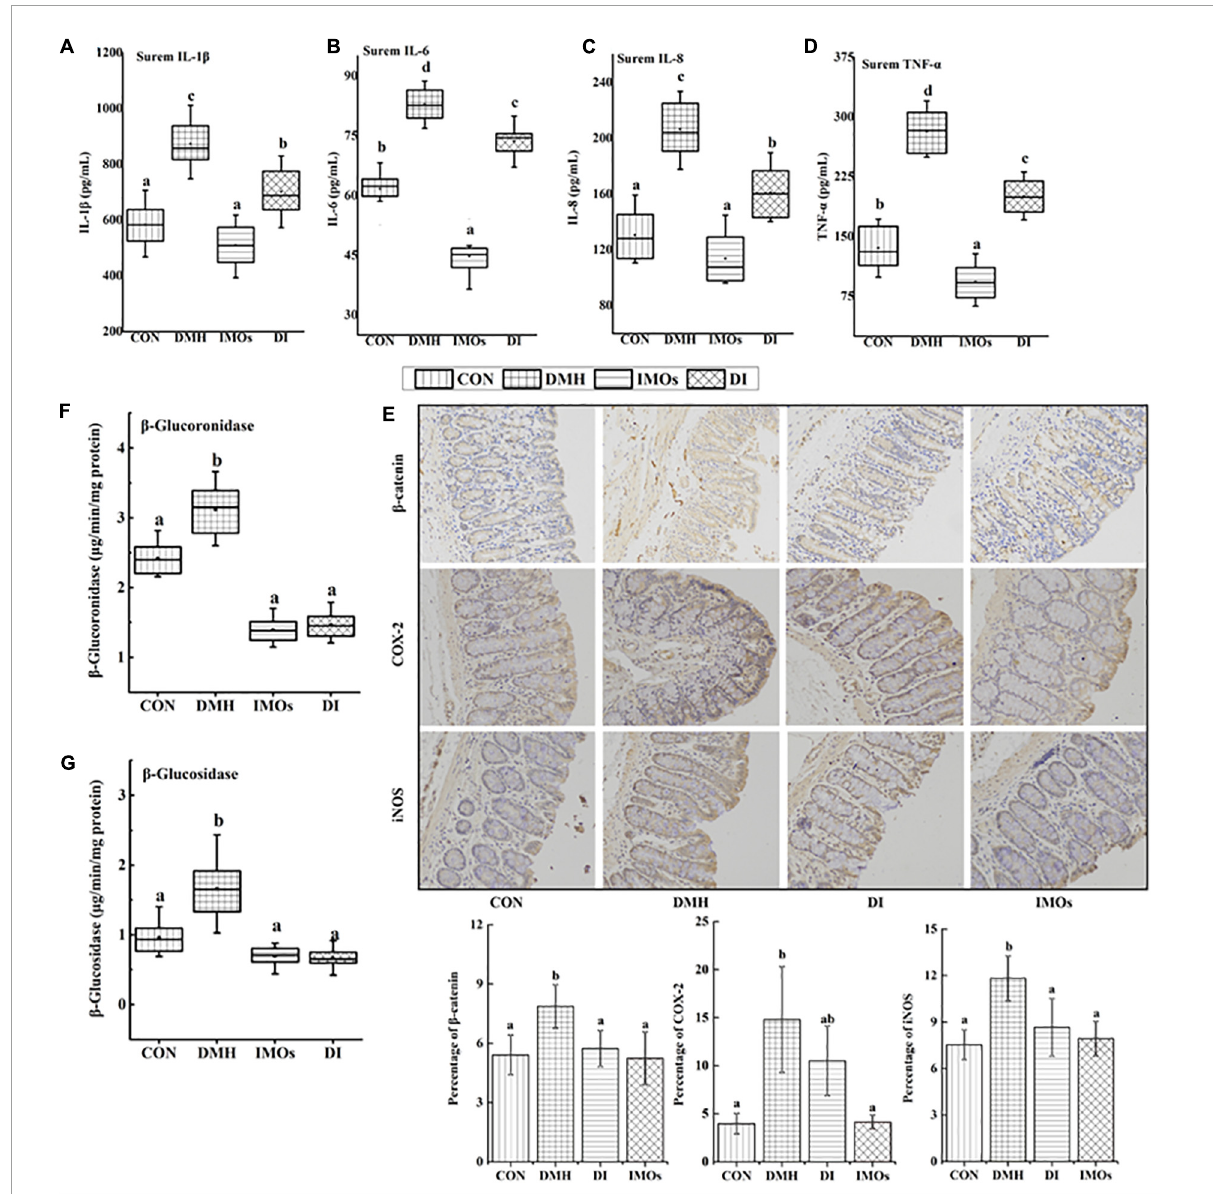
FIGURE2 The levels of (A) IL-1 β , (B) IL-6, (C) IL-8 and (D) TNF- α in rat serum. (E) Immunohistochemistry of β -catenin, COX-2 and iNOS in rat colonic tissue. β -glucoronidase and positive expression rates of β -catenin, COX-2 and iNOS in colonic tissues were analysed using Image Pro-Plus 6.0 software. The levels of (F) β -glucoronidase and (G) β -glucosidase in rat faeces. Values followed by different letters (a, b and c) in each group are significantly different ( p <